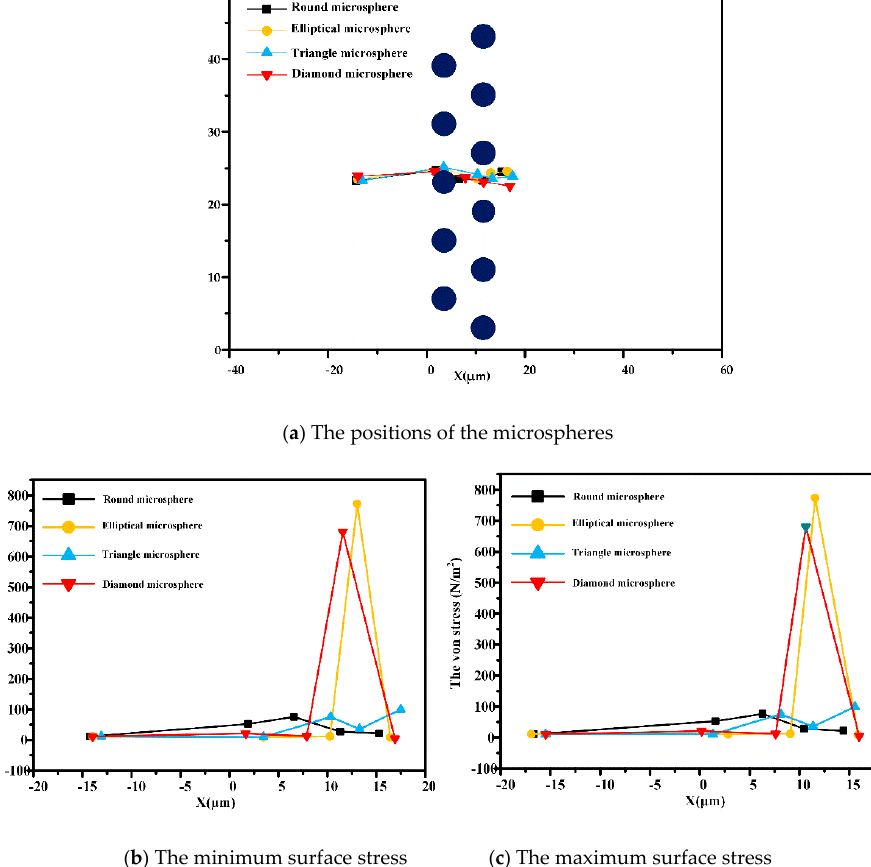
distribution is almost constant and uniform. The surface stress increases with increasing pressure. Circular and triangular microspheres are always symmetrical when they are in movement, so the